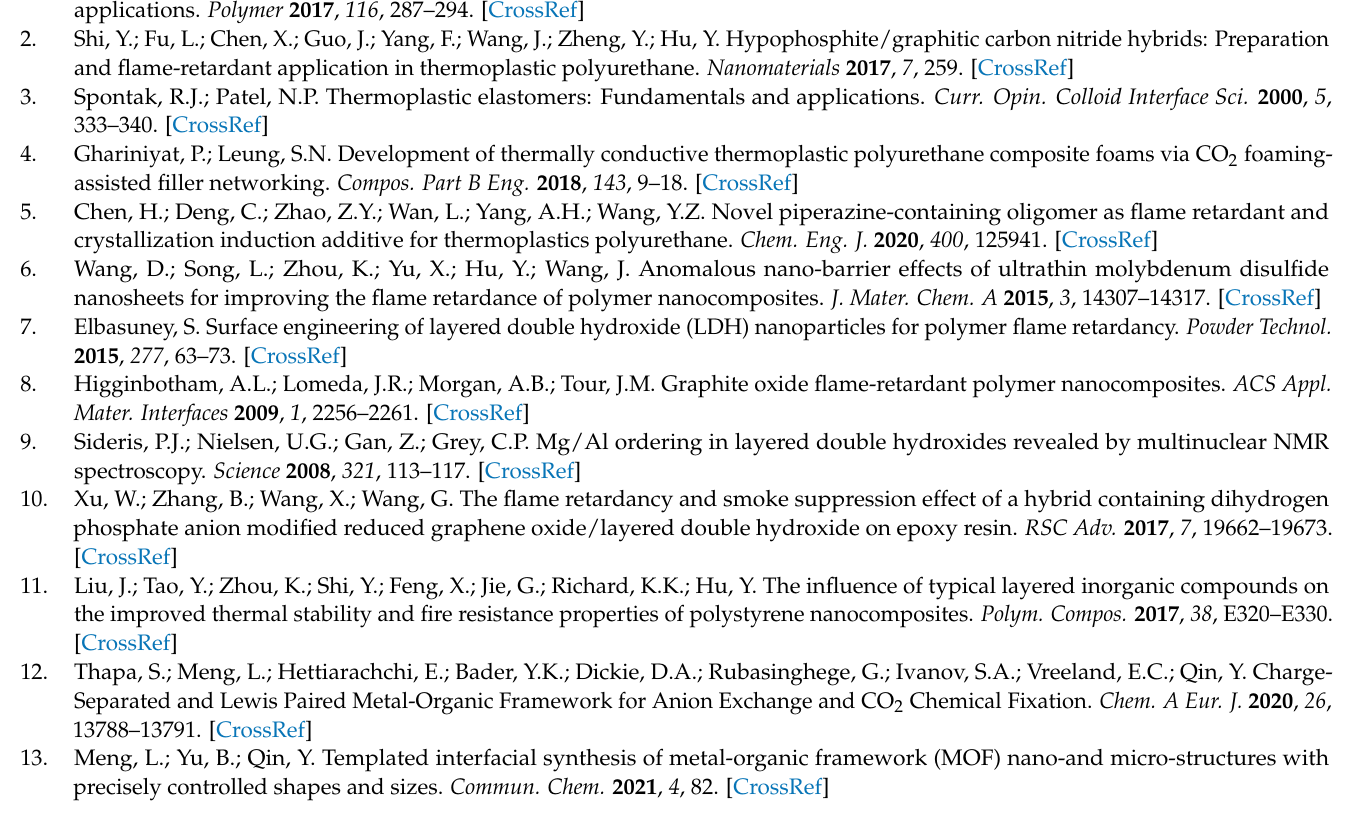
Figure S2: Digital photographs of the char residues of TPU composites; Figure S3: TG-FTIR spectra of thermal decomposition products of TPU0(a) and